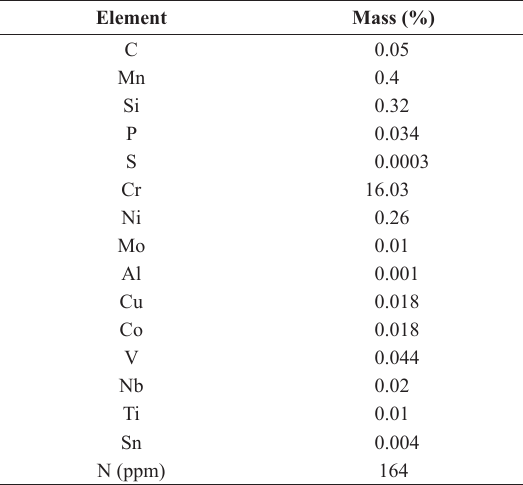
Table 1. Chemical composition of AISI430 ferritic stainless